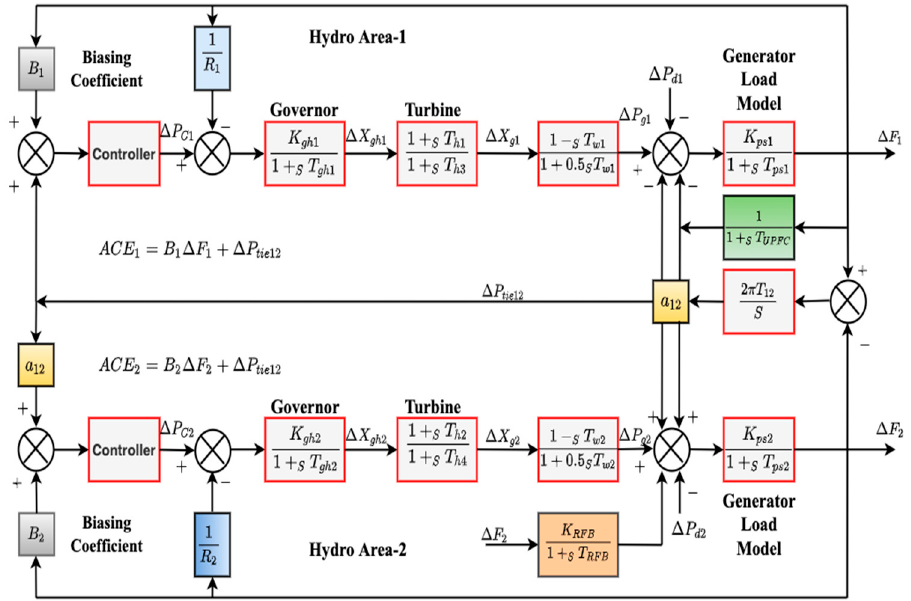
Figure 2. LFC model with hydropower in area-1 interlinked via an AC tie-line to another hydropower plant.